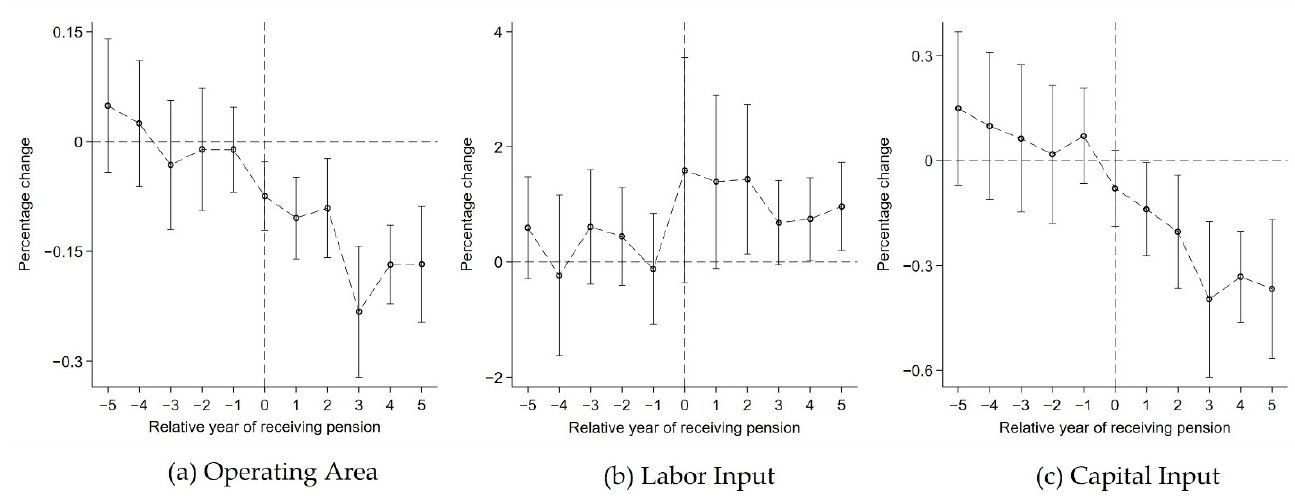
Figure 3. Parallel trend testing.